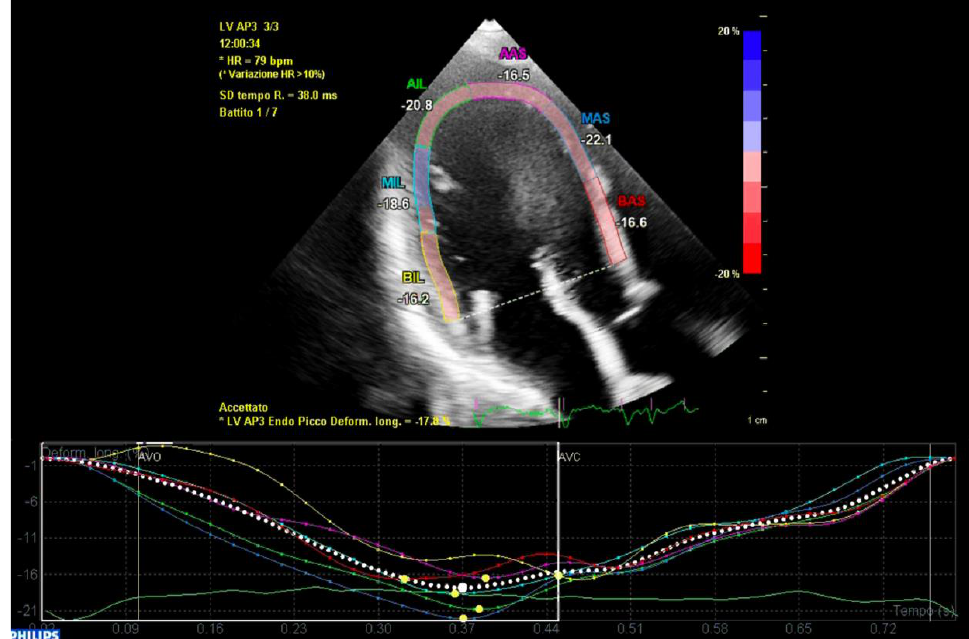
Figure 8. Mechanical dispersion in a patient from the ICD-MVP group. The segments that present greater peak systolic shortening time dispersion are the anterior-septal basal segment (in red) and the inferolateral basal segment (in yellow). Apical segments present a synchronous peak systolic shortening.